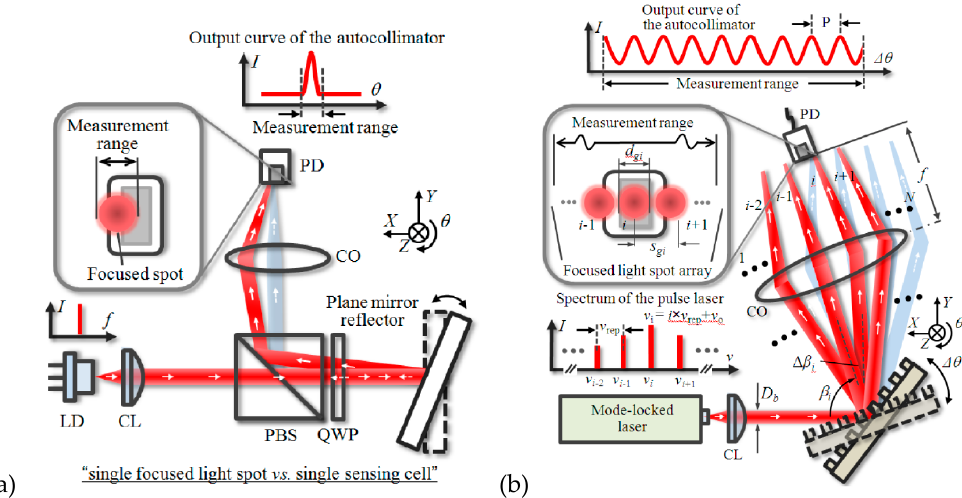
Figure 3. A comparison between the conventional laser autocollimator and the femtosecond laser autocollimator [55]: ( a ) A laser autocollimator with a single-mode laser source; ( b ) A femtosecond laser autocollimator with a mode-locked femtosecond laser source.